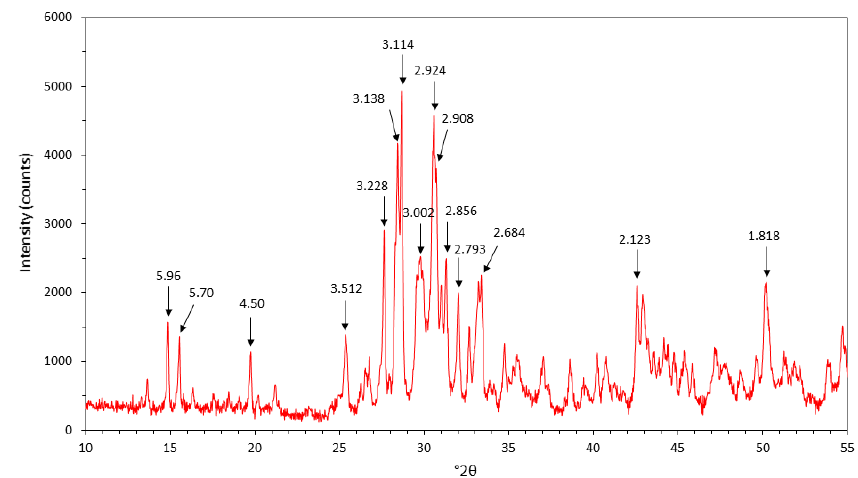
Figure 3. Powder X-ray diffractogram of kesebolite-(Ce). Major Bragg peaks are labeled with the corresponding d values (in Å). Table 5. Crystal data and experimental conditions for the single-crystal XRD